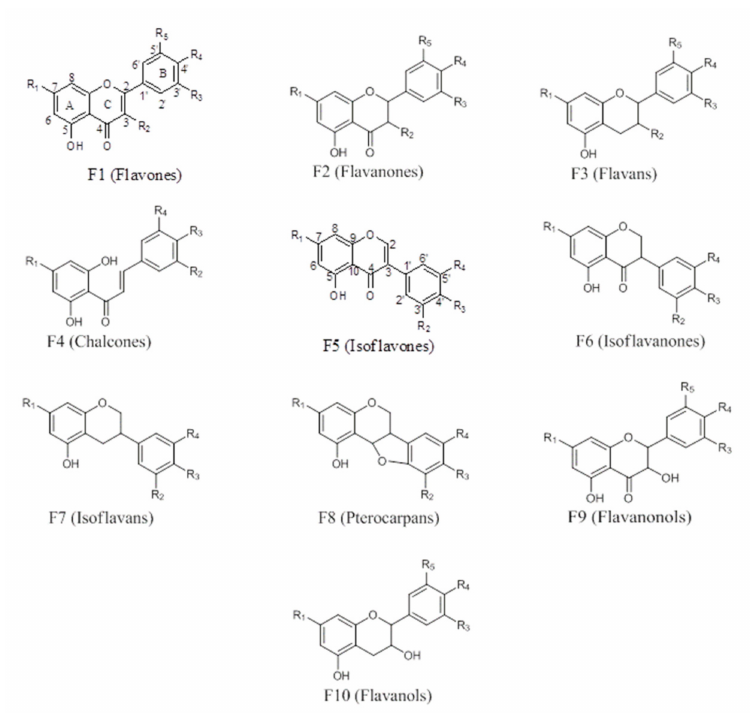
Figure 1. Flavonoid moieties. R1, R2, R3, R4 = H, OH, OCH 3 , O -sugar, prenyl, isoprenyl,